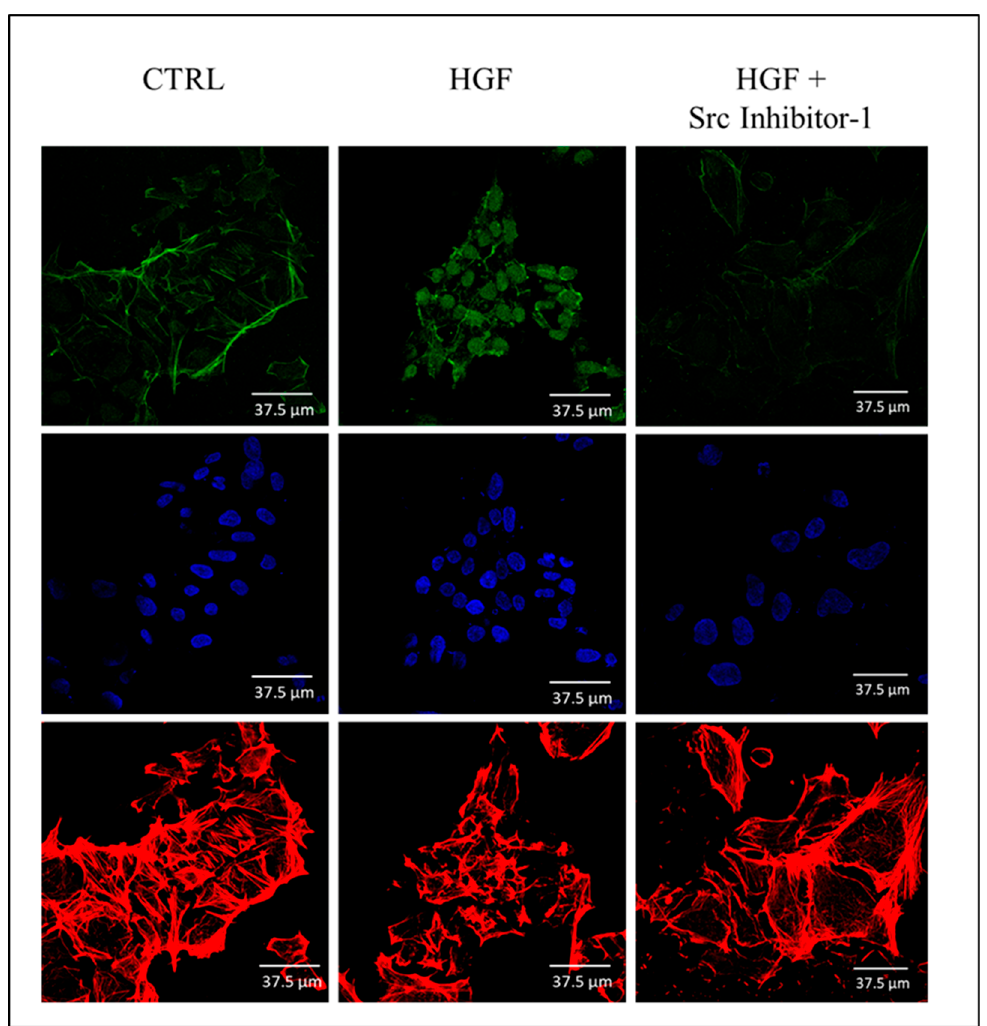
Figure 8. Confocal microscopy analysis of c-Src phospho Tyr416 distribution-pattern: Immunofluorescence analyses of c-Src phospho Tyr416 (FITC, green signal) in NT2D1 cells cultured with or without HGF and Src Inhibitor-1. Actin cytoskeleton (Rhodamin phalloidin, red signal) and nuclei staining (TOPRO-3, blue signal) are also reported in the figure. The nuclear translocation of c-Src phospho Tyr416 after HGF administration is clearly evident. The treatment with Src Inhibitor-1 prevents this phenomenon.